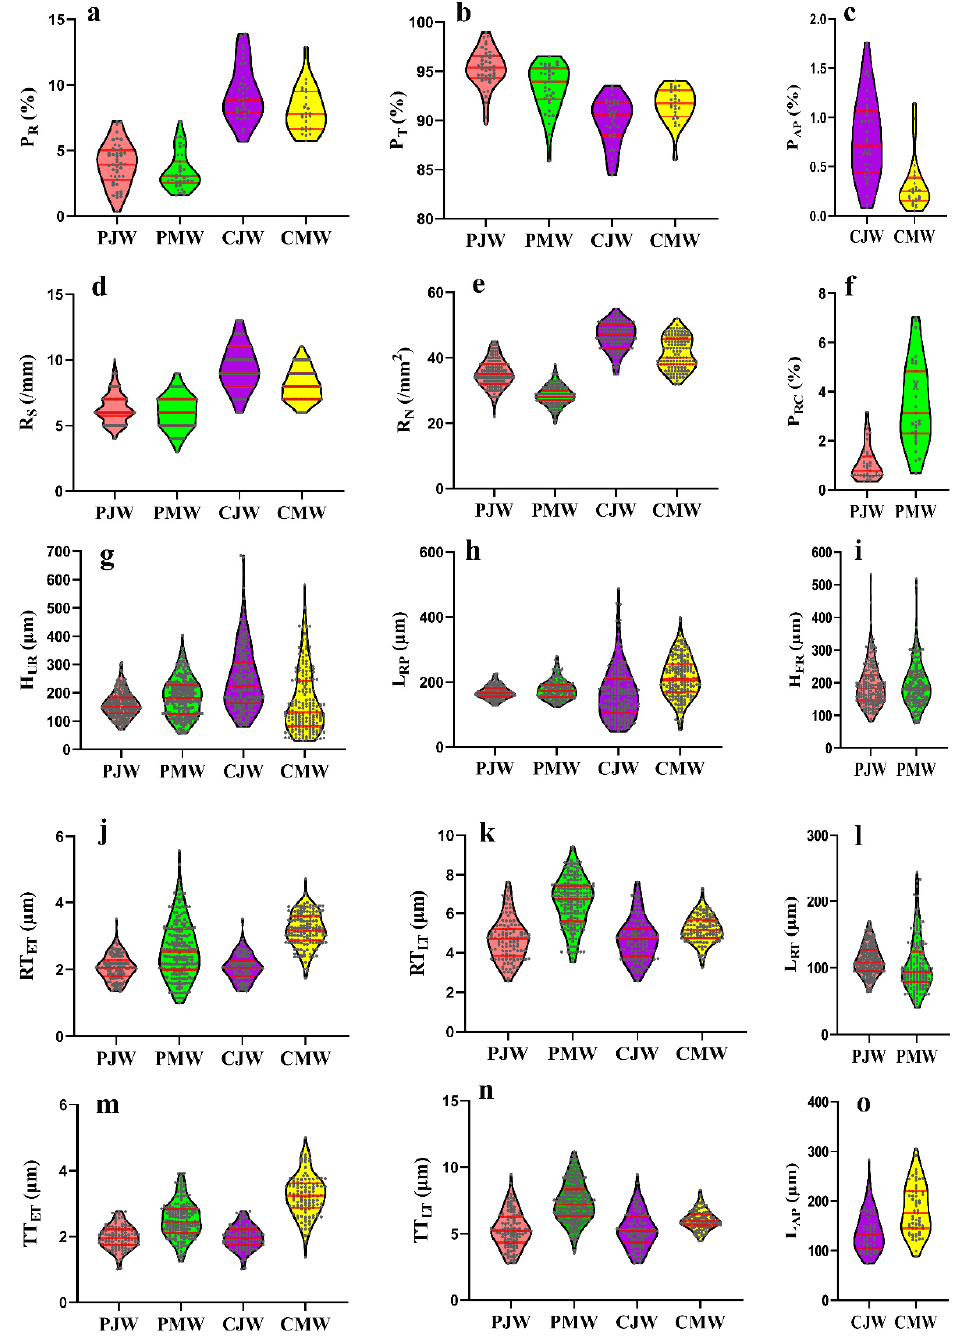
Figure 2. Violin plots of wood anatomical features in juvenile wood and mature wood of Masson pine and Chinese fir. PJW: juvenile Masson pine, PMW: mature Masson pine, CJW: juvenile Chinese fir, CMW: mature Chinese fir. ( a ) P R , the percentage of rays, ( b ) P T , the percentage of axial tracheids, ( c ) P AP , the percentage of axial parenchyma, ( d ) R S , the ray spacing, ( e ) R N , the ray number, ( f ) P RC , the percentage of axial resin canals, ( g ) H UR , the uniseriate ray height, ( h ) L RP , the ray parenchyma cell length, ( i ) H FR , the fusiform ray height, ( j ) L RT , the ray tracheid length, ( k ) L AP , the axial parenchyma cell length, ( l ) RT ET , the radial wall thickness of earlywood axial tracheid, ( m ) RT LT , the radial wall thickness of latewood axial tracheid, ( n ) TT ET , the tangential wall thickness of earlywood axial tracheid and ( o ) TT LT , the tangential wall thickness of latewood axial tracheid.